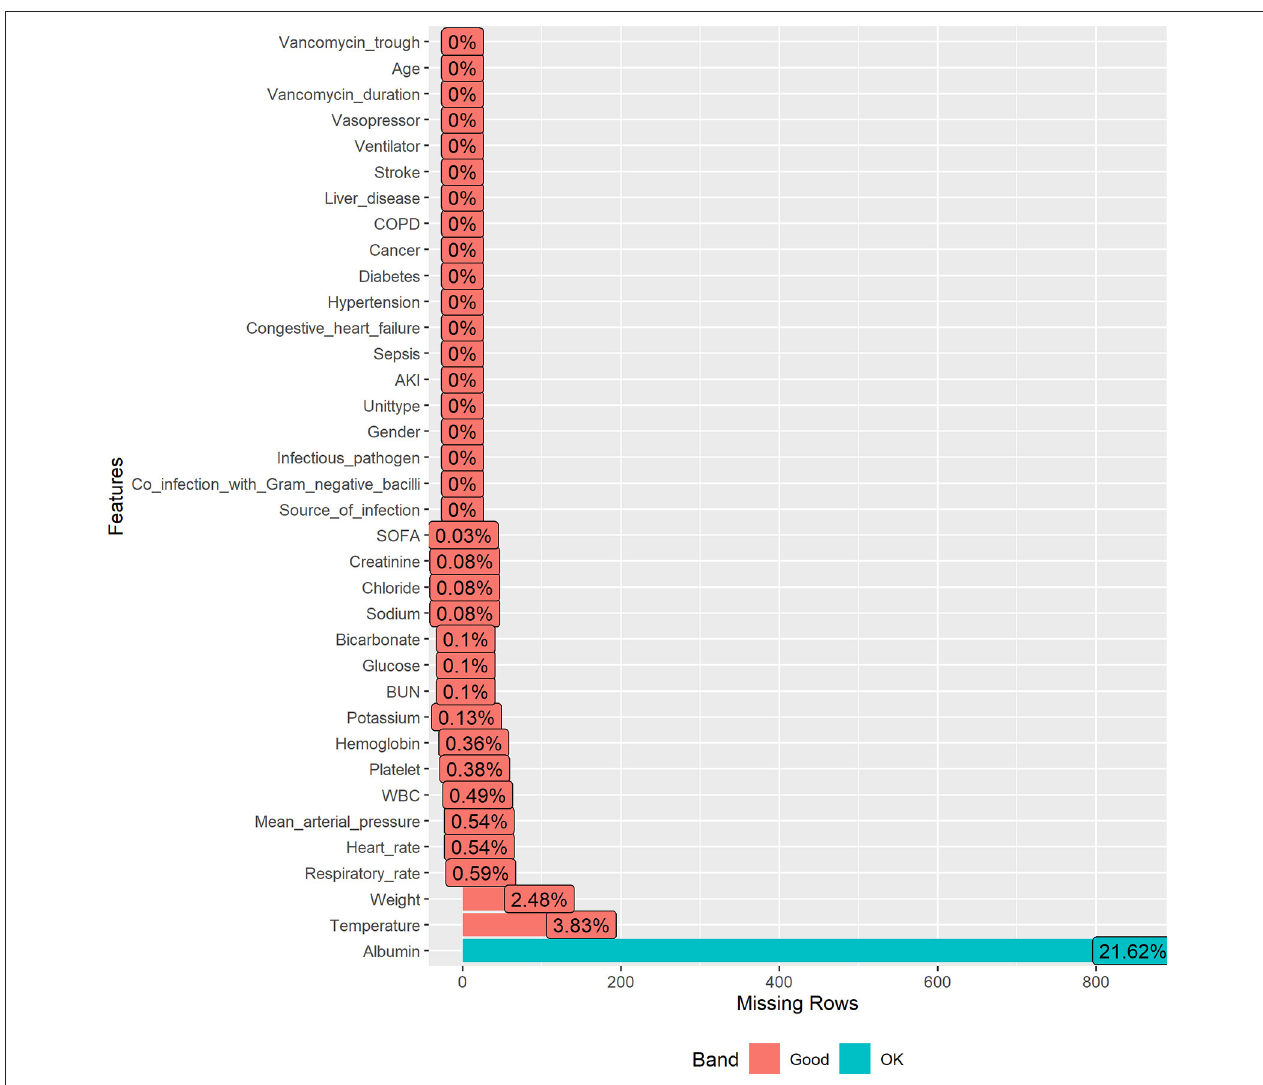
FIGURE 2 | Specific missing rates for